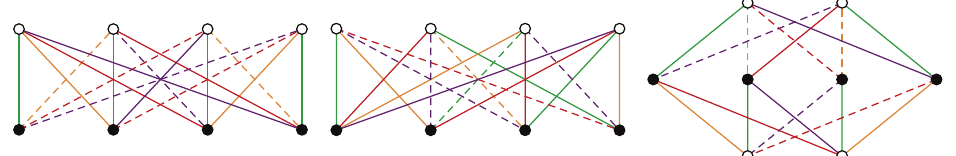
Figure 2: Three Adinkras belonging to the same equivalence class. The first two are isomorphic, whereas the third belongs to a separate isomorphism